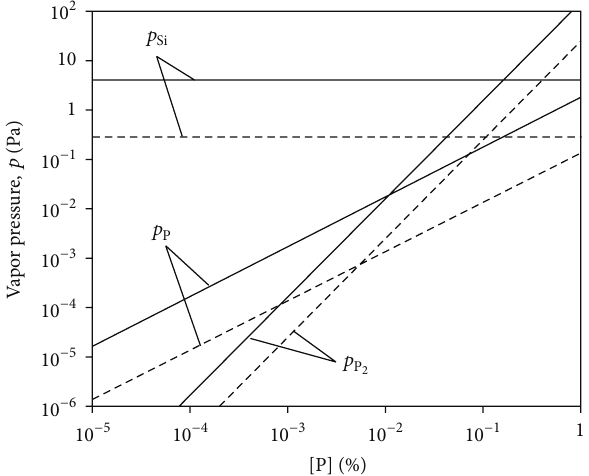
Figure 3: Equilibrium vapor pressure of impurity P and Si at 1800 K (broken line) and 2000 K (solid